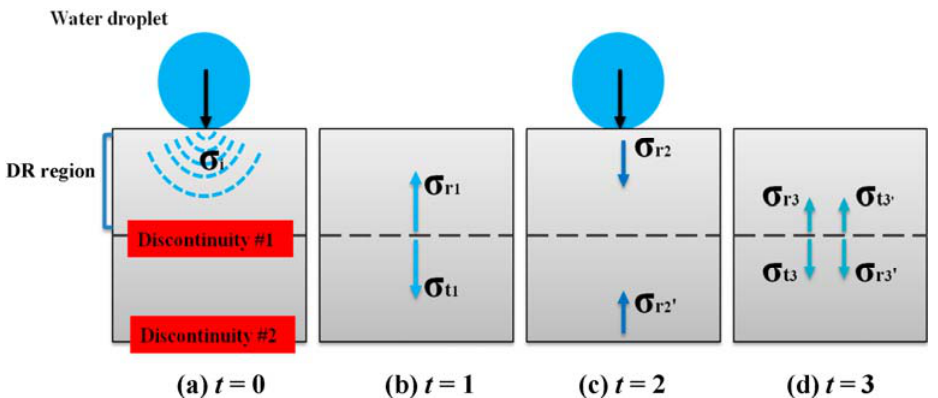
Figure 16. Stress wave directions during LIE ( t stands for time).